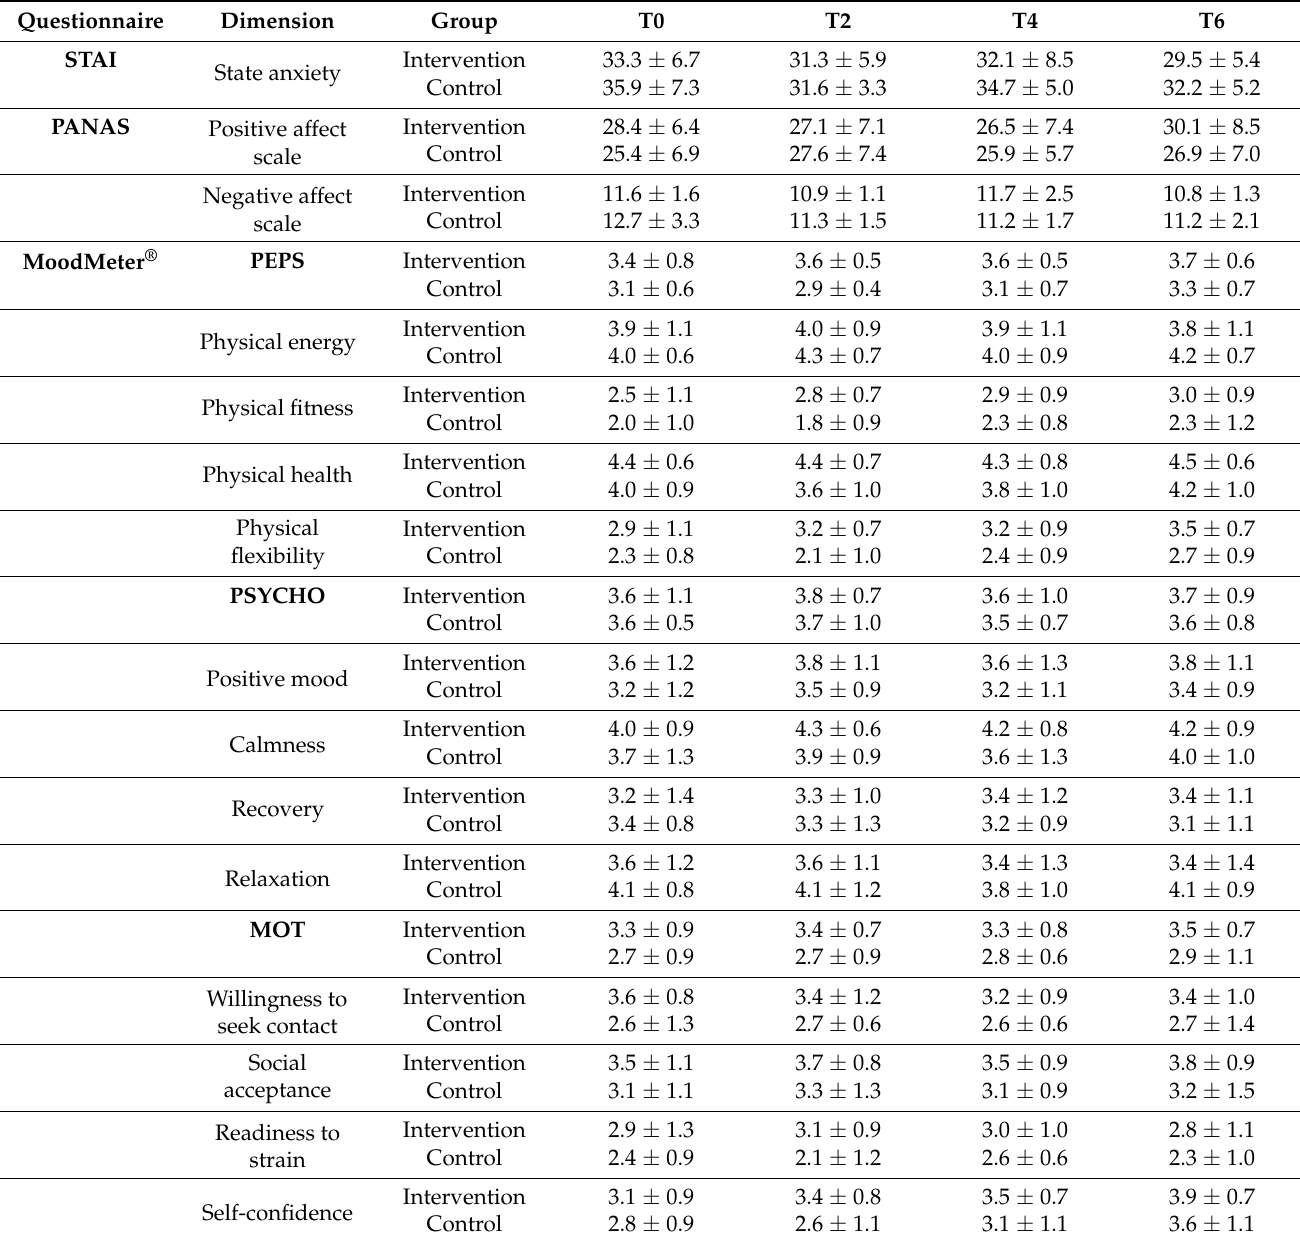
Table 2. Behavioral data of the mood questionnaires. Mean ± standard deviation values for both groups (IG and CG) and for each timepoint (baseline (T0), after two (T2), four (T4), and six (T6)